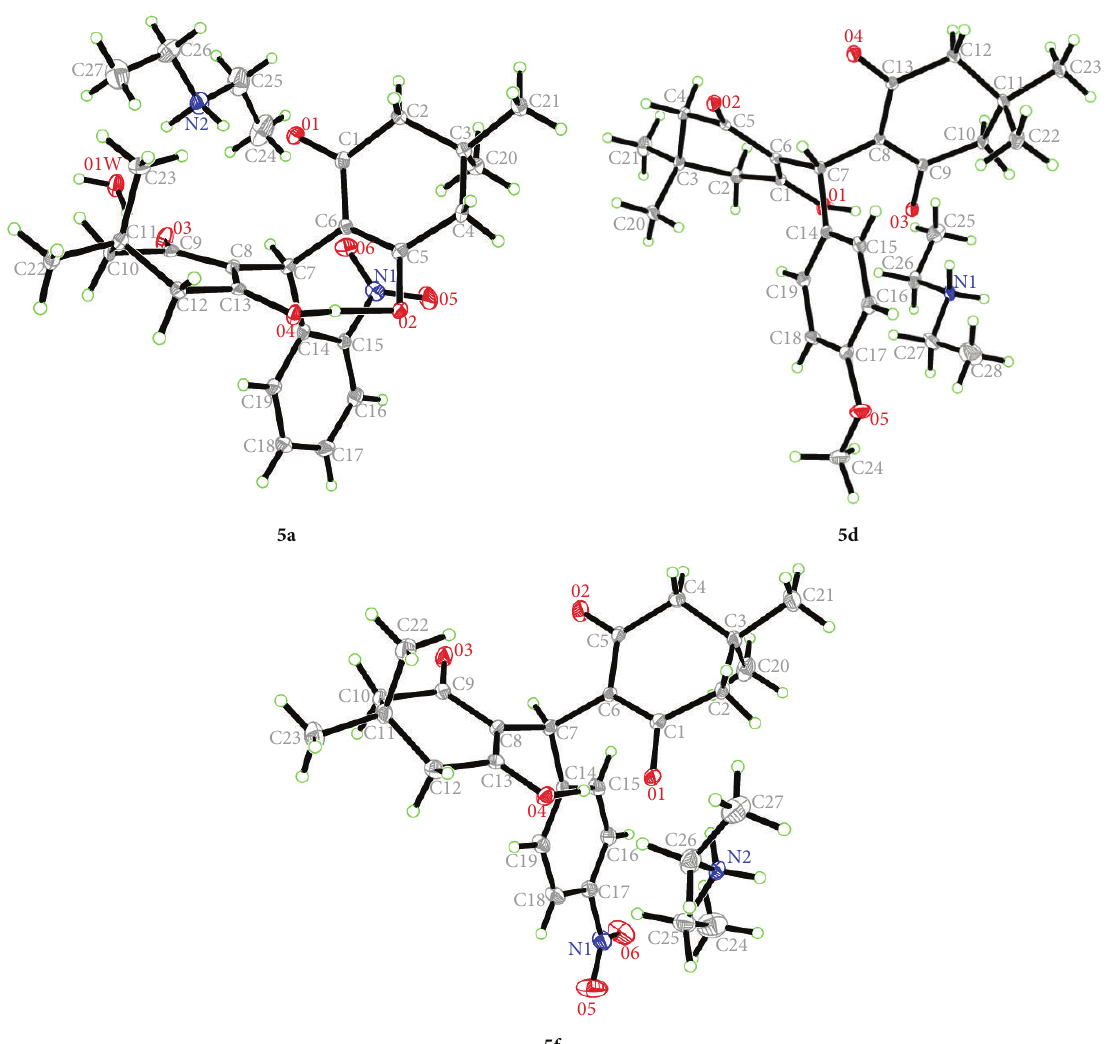
Figure 2: ORTEP diagram of 5a , 5d , and 5f . Displacement ellipsoids are plotted at the 40% probability level for non-H atoms.